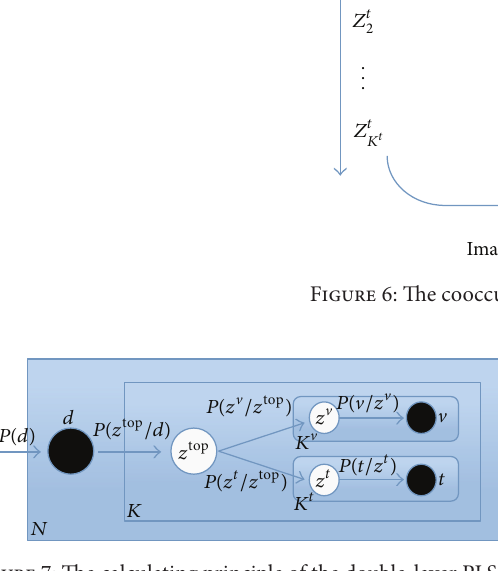
Figure 8: The tagging process of the